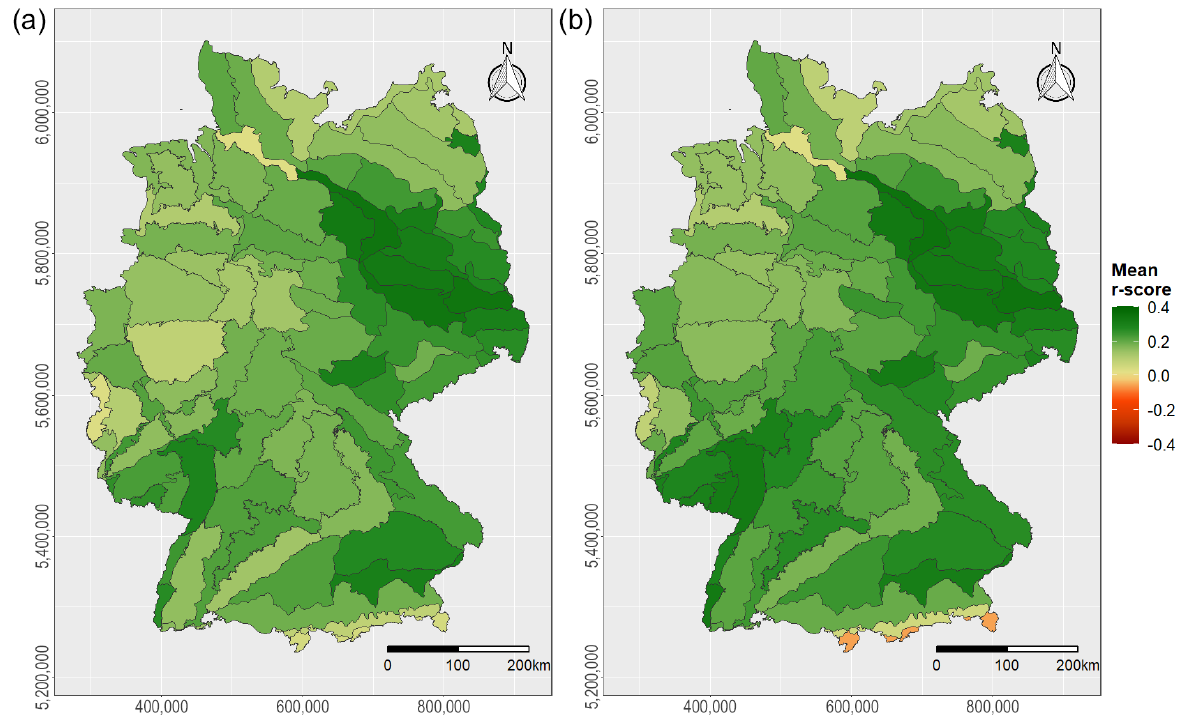
Figure A3. Mean correlation coefficients between scPDSI and ( a ) MODIS ∆ Harmonic NDVI as well as ( b ) MODIS z-score NDVI values for each main natural unit in Germany after Schmithüsen and Meynen [99], who divided Germany into 86 nature units based on climatic characteristics, soil types and topographic